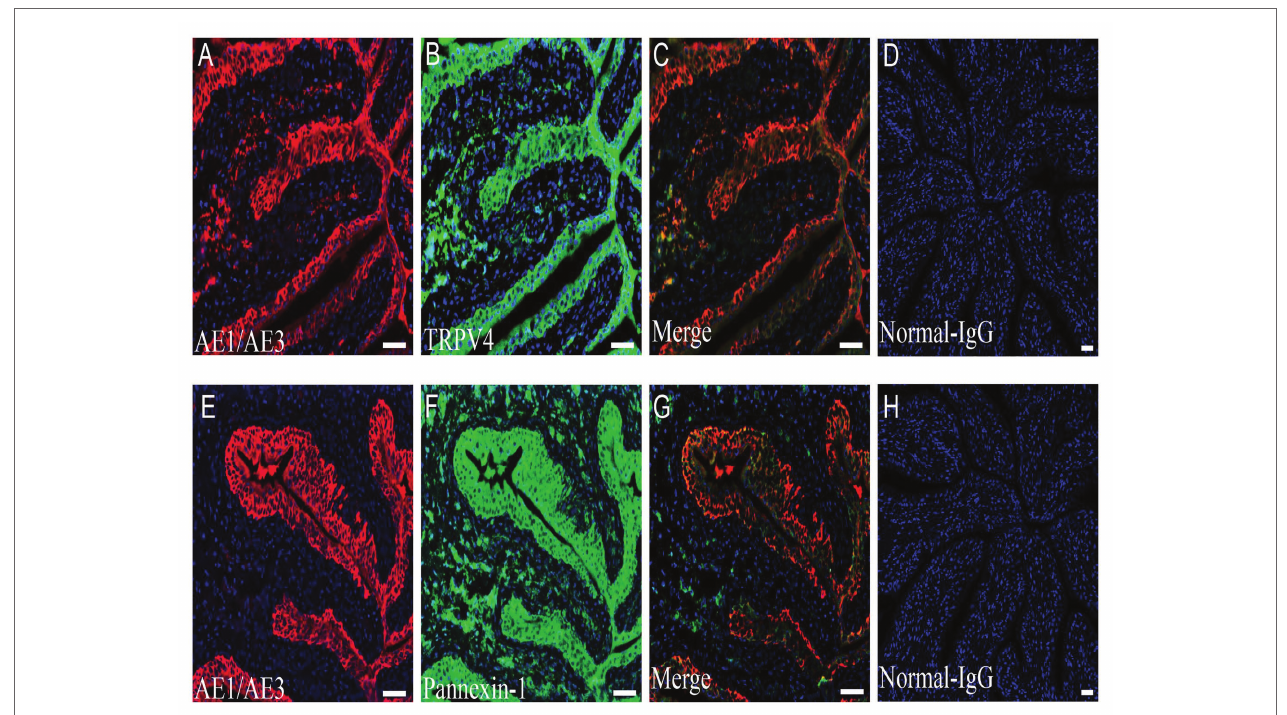
FIGURE 6 | Expression of TRPV4 and pannexin 1 channel on the rat bladder urothelium. (A–C) Urothelial cell marker AE1/AE3-IR (red, A ); TRPV4-IR (green, B ); and double staining (yellow, C ) in the urothelial layer. (E–G) Urothelial cell marker AE1/AE3-IR (red, E ); pannexin 1-IR (green, F ); and double staining (yellow, G ) in the urothelial layer. (D,H) Image with normal rabbit IgG. Blue color in all panels represents nuclear staining by 4 ' ,6-diamidino-2-phenylindole (DAPI). TRPV4-IR and pannexin 1-IR span from the basal layer to umbrella cells. All panels are shown at the same magnification. Scale bars represent 100 μ